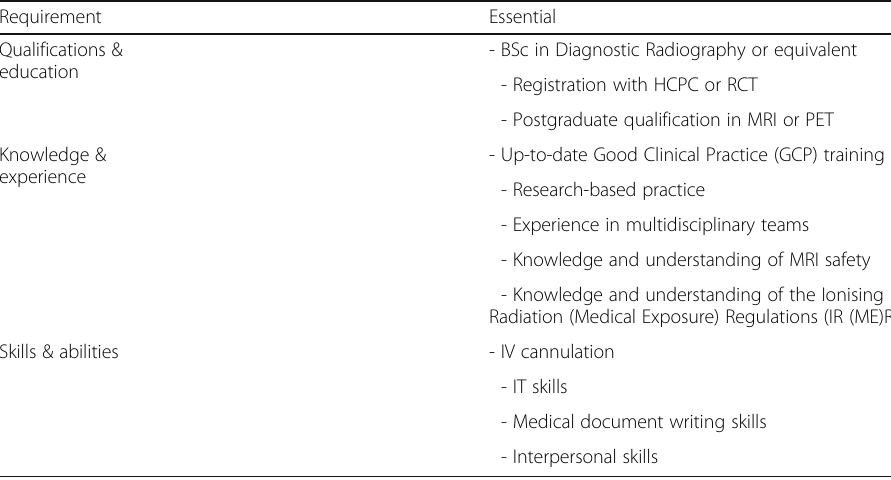
Table 2 Essential competencies listed in the Job Description of PET/MRI radiographers or